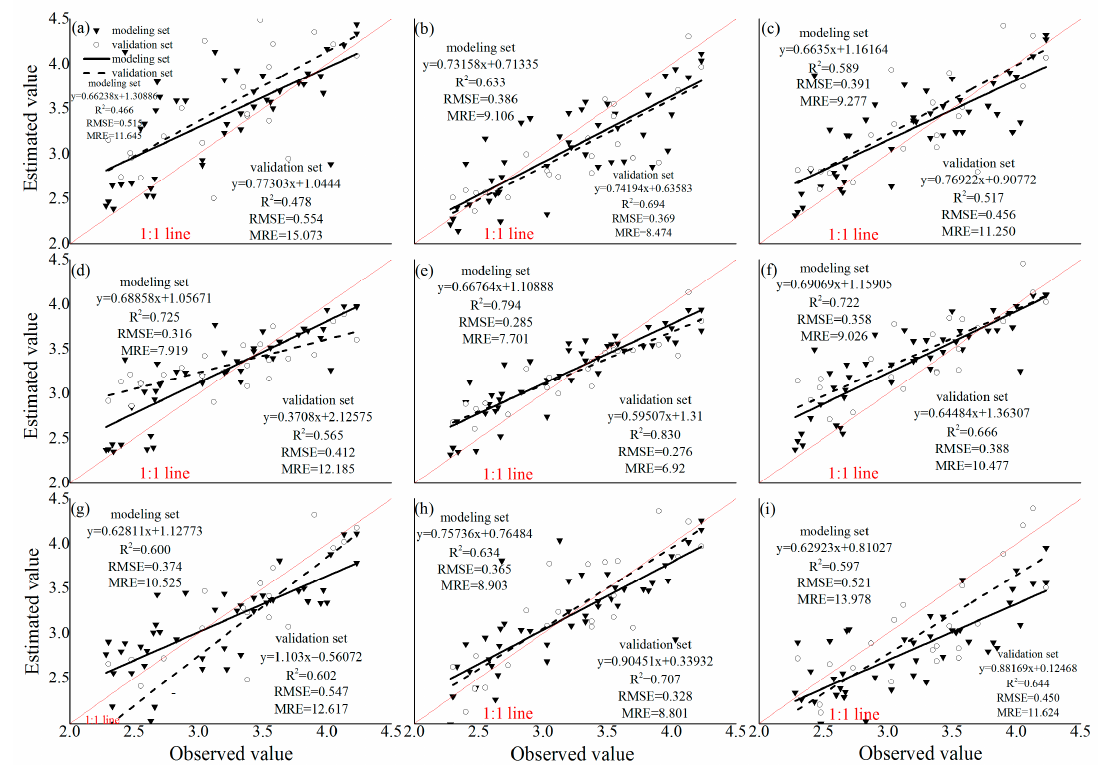
Figure 5. Prediction results of modeling set and validation set of winter wheat leaf area index inver-